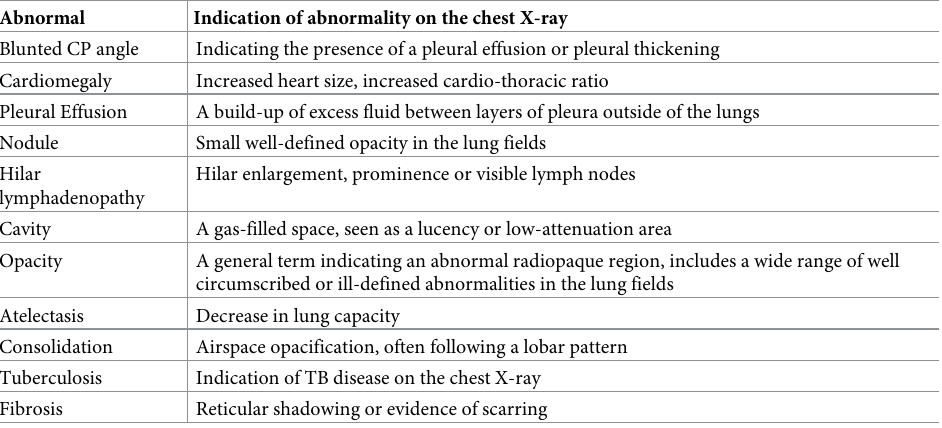
Table 1. Qure.ai qXR (http://qure.ai/qxr/) TB deep learning classifiers. Abnormal Indication of abnormality on the chest